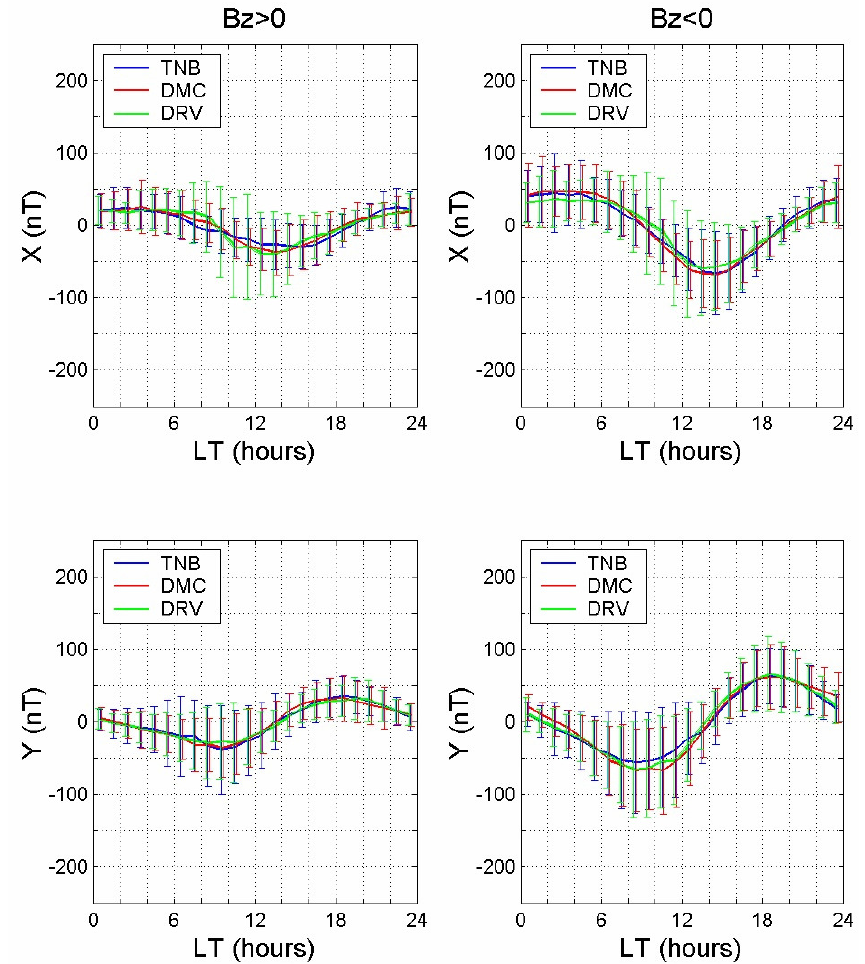
Fig. 7. Daily distribution of the average hourly values and their standard deviation for the X and Y components, separately for northward (left panels) and southward (right panels) IMF